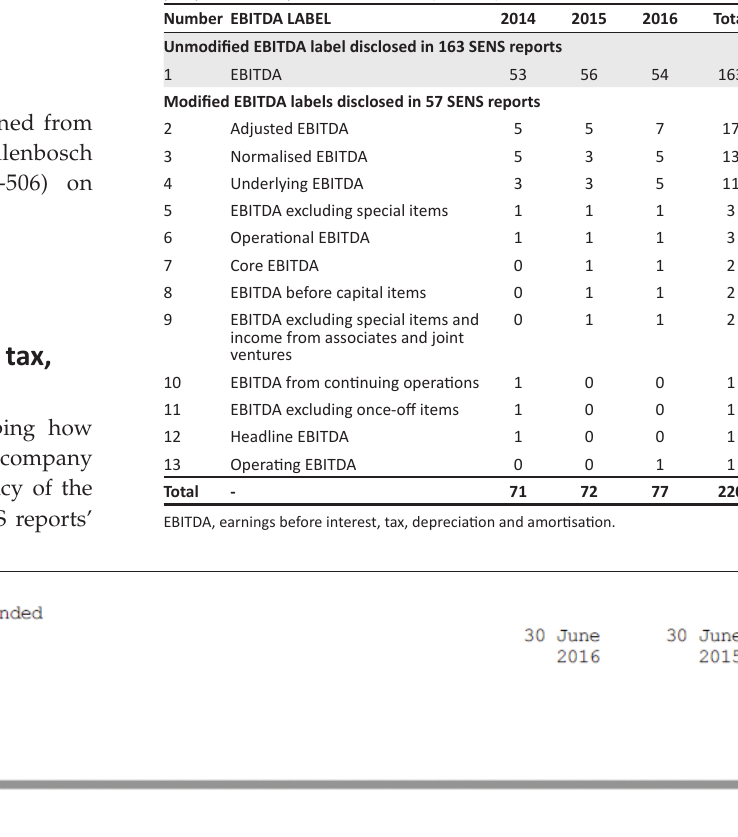
TABLE 3: List of earnings before interest, tax, depreciation and amortisation labels in Stock Exchange News Service reports and the frequency of occurrences per year for the period 2014–2016 ( N = 220).